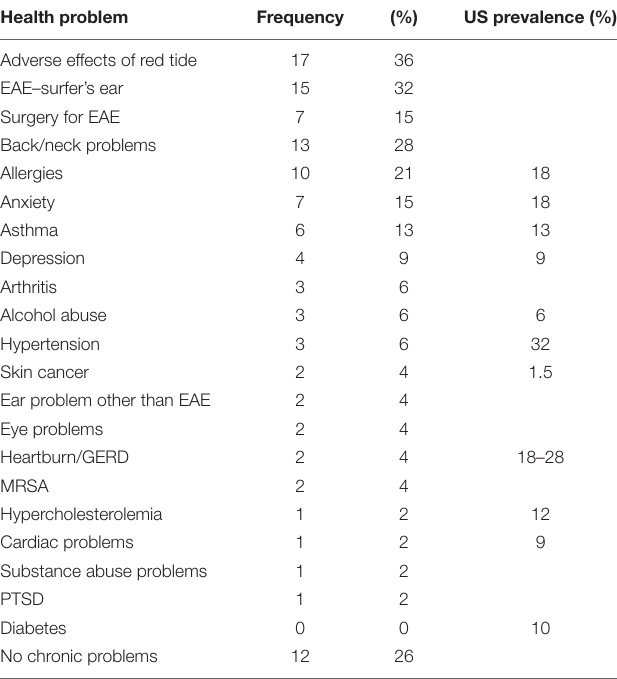
TABLE 2 | Acute and chronic health problems in the study participants ( N =